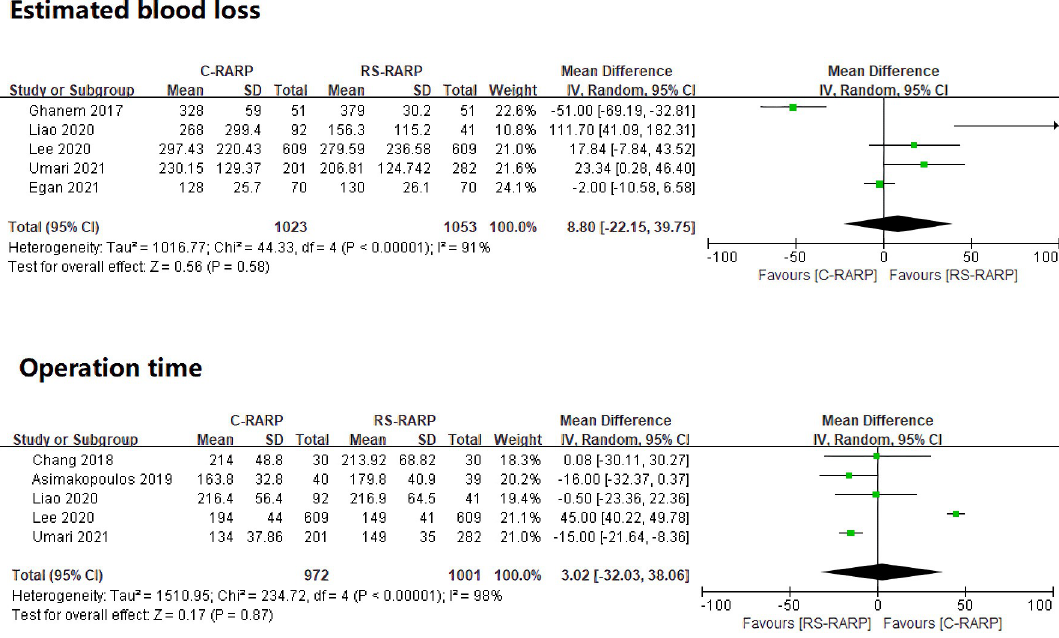
Fig 5. Forest plots of estimated blood loss and operation time.